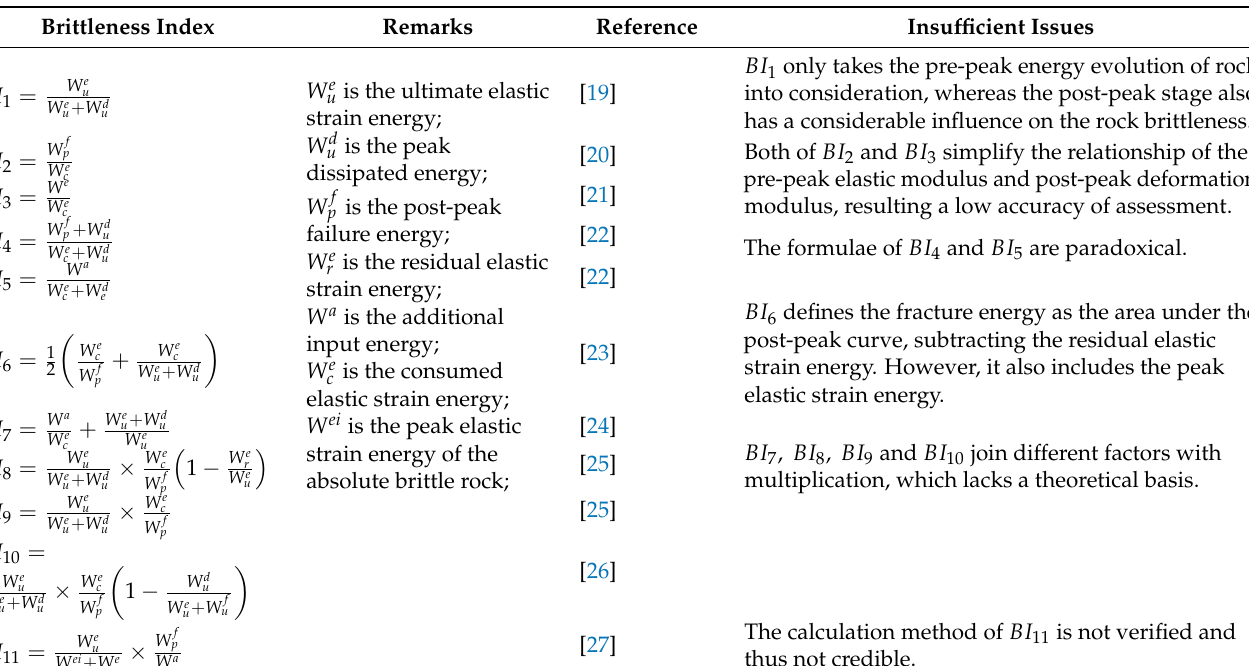
Table 1. Summary of existing rock brittleness indices based on the energy evolution